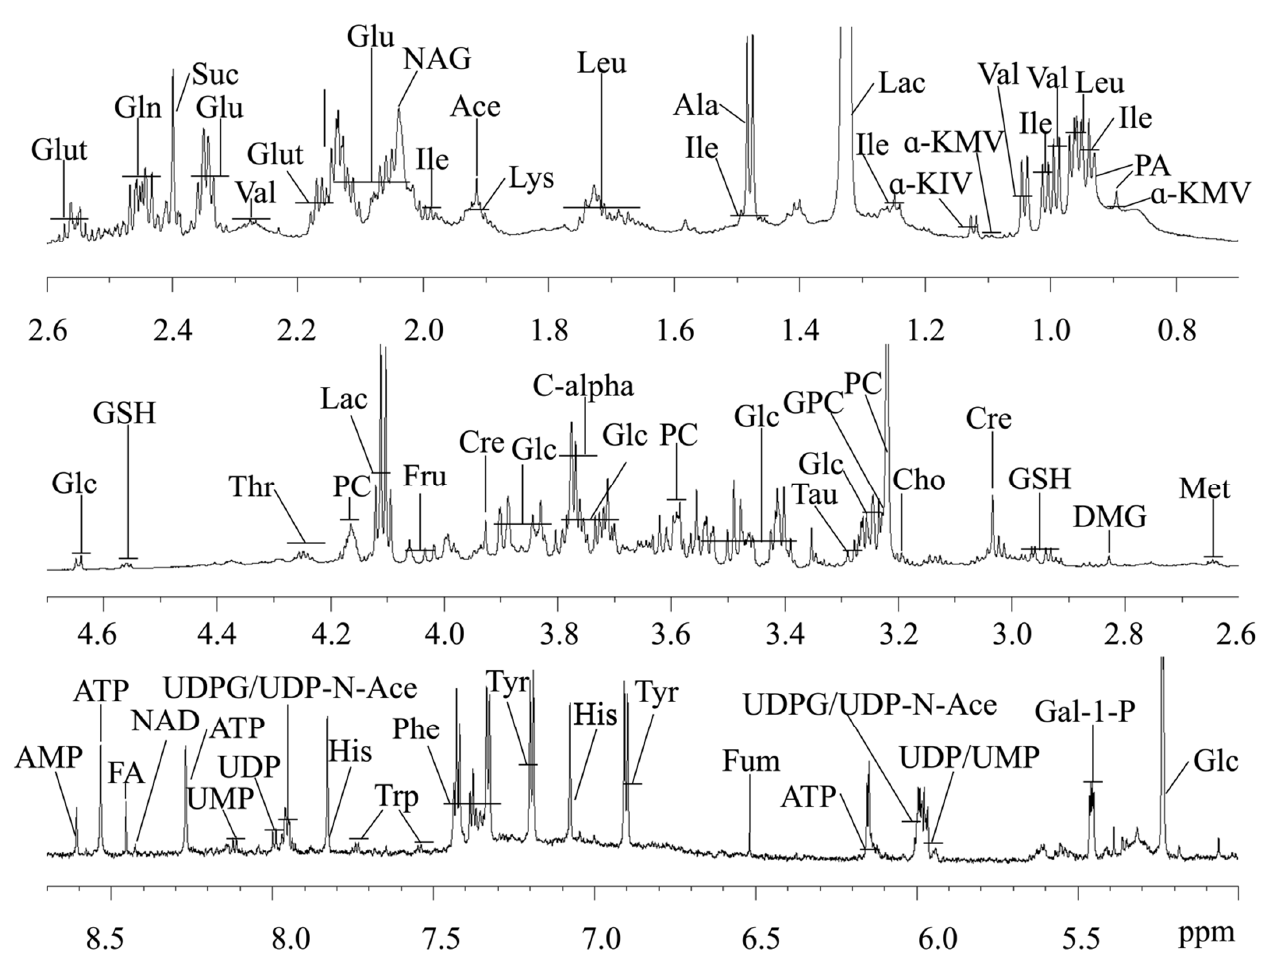
Figure 2. Typical 1 H NMR spectra from the cell extracts. Keys: PA, Pantothenate; Ile, Isoleucine; Leu, Leucine; Val, Valine; α -KIV, α -Keto-isovalerate; α -KMV, α -keto-beta-methyl-valerate; Lac, Lactate; Ala, Alanine; Thr, Threonine; Glu, Glutamate; Gln, Glutamine; NAG, N-Acetyl-Glutamine; Suc, Suc- cinate; Met, Methionine; DMG, Dimethylglycine; Cre, Creatine; Cho, Choline; PC, Phosphocholine; GPC, Glycerophosphocholine; Tau, Taurine; GSH, Glutathione; Glc, Glucose; Fru, Fructose; Gal-1- p , Galactose-1-phosphate; Tyr, Tyrosine; Phe, Phenylalanine; Fum, Fumaric acid; NAD + , Nicotina- mide adenine dinucleotide; FA, Formate; His, Histidine; AMP, Adenosine monophosphate; ATP, Adenosine triphosphate; UMP, Uridine 5 ′ -monophosphate; UDP, Uridine-5 ′ -diphosphate; UDPG, UDP Glucuronate; UDP- N -Ace, UDP- N -acetylglucosamine; C-alpha, The central carbon atom in amino acids.